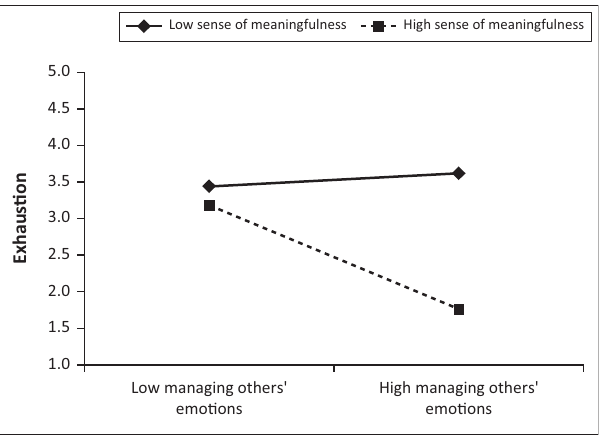
FIGURE 2: Interaction effect (perceptions of emotions x sense of meaningfulness) in predicting exhaustion.